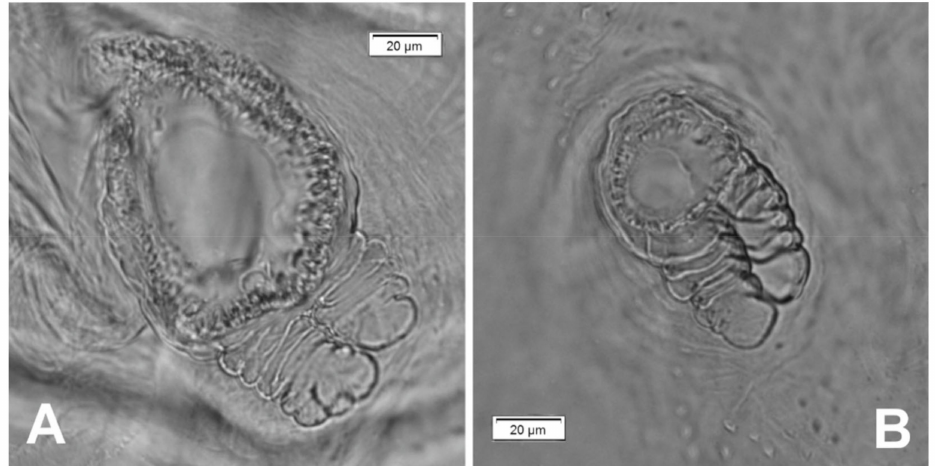
Figure 13. Rhinocyllus alpinus mature larva, spiracles. ( A )—spiracle of prothorax; ( B )—spiracle of abdominal segment